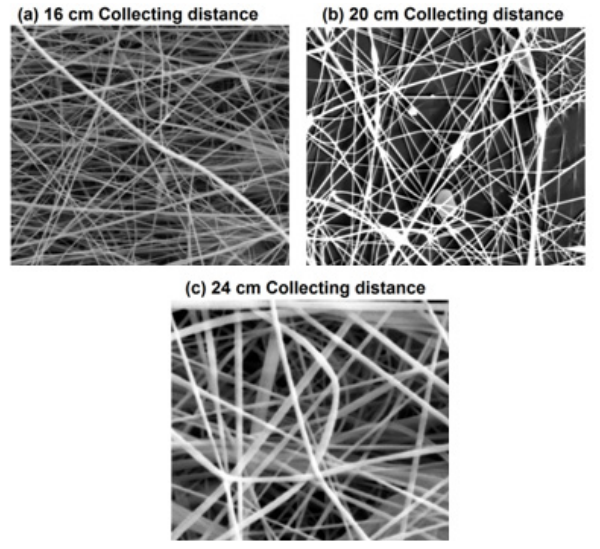
Figure 6. SEM images of nanofibers influencing the collecting distance 16 cm, 20 cm, and 24 cm at a constant voltage of 45 kV and with a constant polymer concentration of 20%.